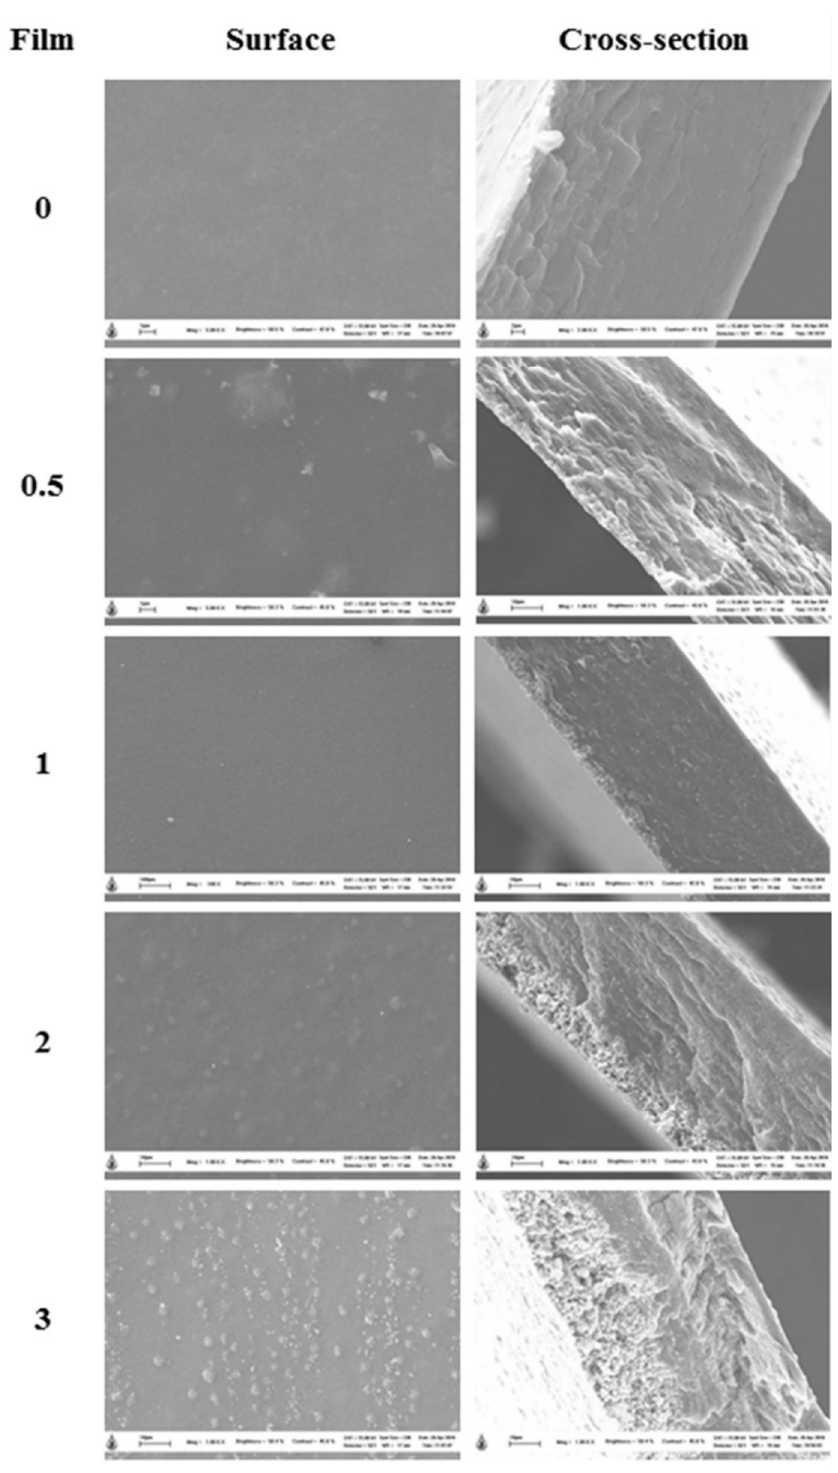
Figure 3. SEM micrographs of surface (magnification: 5000 × ) and cross-section (magnification: 2000 × ) of RS–G films containing different concentrations of ZnONPs. Numbers denote the ZnONPs concentrations (%, w / v ).